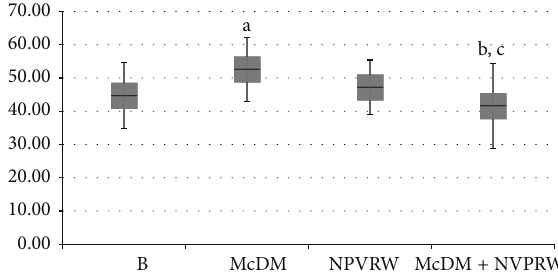
Figure 2: Comparative values of ox-LDL level for each treatment intervention. The significant values are expressed as (a) baseline versus McDonald’s meal ( 𝑃 ≤ 0.05 ); (b) McDonald’s meal versus McDonald’s meal + not pruned vineyard red wine ( 𝑃 ≤ 0.05 ); (c) baseline versus not pruned vineyard red wine ( 𝑃 > 0.05 ); baseline versus McDonald’s meal + not pruned vineyard red wine ( 𝑃 > 0.05